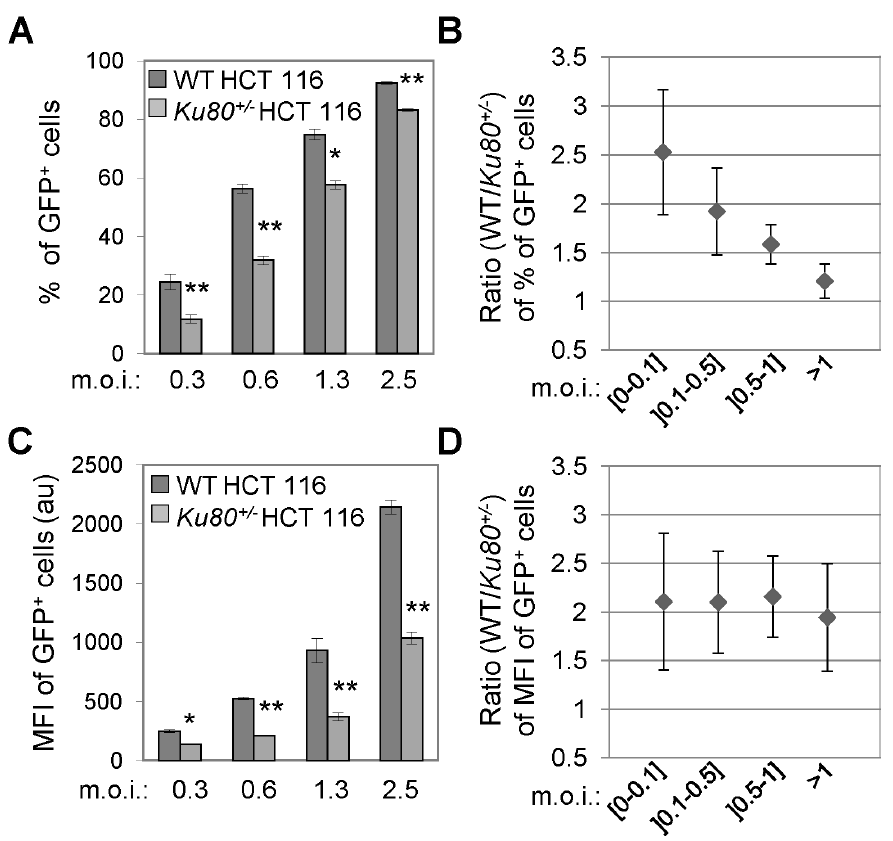
Figure 2. Ku80 haplodepletion reduces HIV-1-driven GFP expression. ( A – D ) Wild-type (WT) and Ku80 + / 2 human colon carcinoma HCT 116 cells were transduced at the depicted multiplicity of infection (m.o.i.) with XCD3 (HIV-1 env - nef - IRES- gfp ) as indicated and were analyzed 48 h later by cytofluorometry for the percentage and the geometric mean fluorescence intensity (MFI) of green fluorescent protein-positive (GFP + ) cells. Panels ( A ) and ( C ) present the results of the percentage and the MFI of GFP + cells, respectively, obtained from at least two independent experimentations at the indicated m.o.i. (mean 6 SD; *, p , 0.05; **, p , 0.01), except for the last m.o.i. for which one representative experiment (of 2 independent observations yielding similar results) is presented (mean 6 SD). The ratios between WT and Ku80 + / 2 HCT 116 cells for the percentage and the MFI of GFP + cells at the depicted m.o.i. are reported in panels ( B ) and ( D ), respectively (mean 6 SD, n =3). au, arbitrary units.